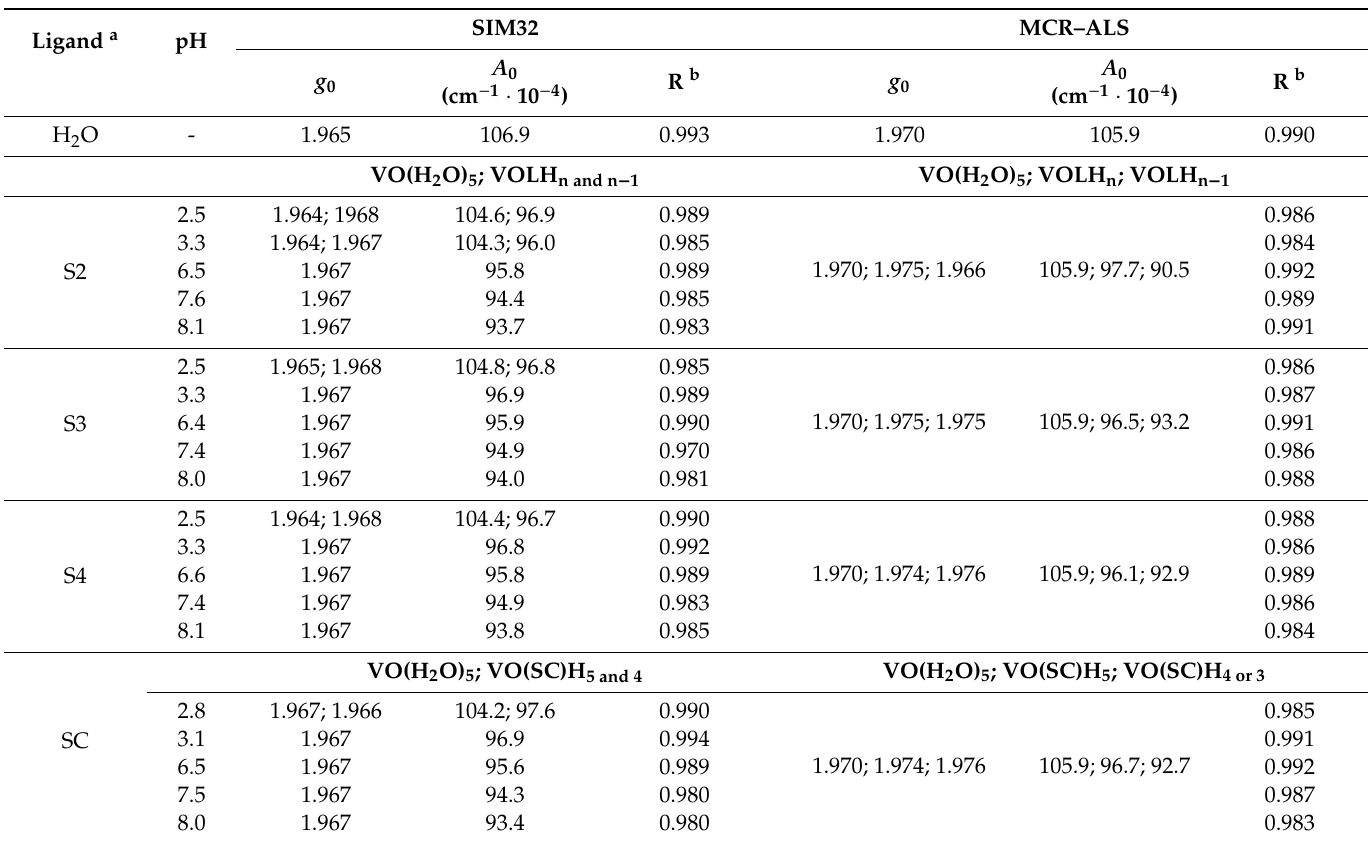
Table 3. RT EPR data. Isotropic hyperfine coupling constant ( A 0 ) and isotropic g values ( g 0 ) of the species obtained by the analysis of EPR spectra recorded on the di ff erent oxovanadium(IV)–ligand system, as a function of pH. Errors in g and A values were estimated to be ± 0.002 and ± 0.5 × 10 − 4 cm − 1 ,